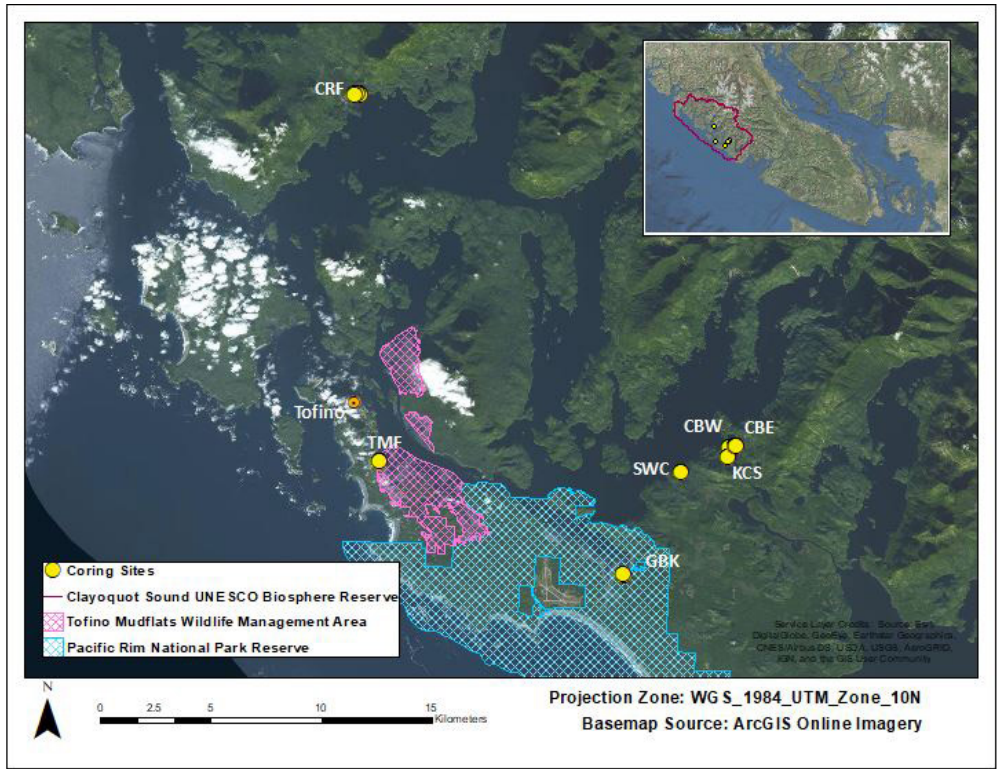
Figure 1. Site locations. Cypress River Flats (CRF), Cannery Bay East (CBE), Cannery Bay West (CBW), Kennedy Cove South (KCS), Shipwreck Cove (SWC), Grice Bay at Kootowis Creek (GBK), and Tofino Mudflats (TMF). Pacific Rim National Park and Reserve (blue crosshatching) covers the southern portion of the map and the Tofino Mudflats Wildlife Management Area (pink crosshatching) covers portions of the southwestern area. The study region lies within the UNESCO Clayoquot Sound Biosphere Reserve, British Columbia, Canada (inset,